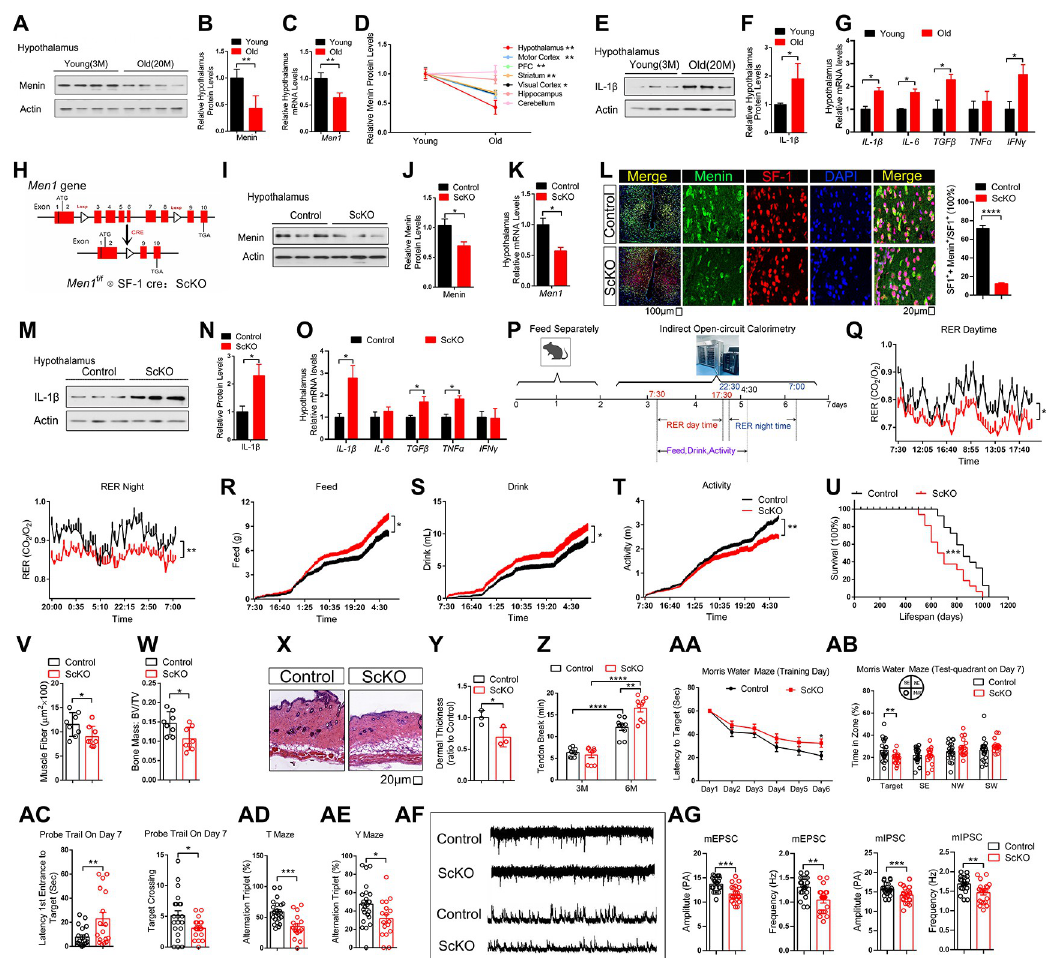
Fig 1. Reduced Menin in the hypothalamus accelerates systemic aging. AU : AbbreviationlistshavebeencompiledforthoseusedinFigs 1 to 6 : Pleaseverifythatallentriesarecorrect : (A–C) Menin protein expression and mRNA levels in the hypothalamus of young (3M) and old (20M) mice; n = 4 mice. (D) Menin protein expression levels in 7 regions of young (3M) and old (20M) mice brain; n = 4 mice. Actin serves as a loading control. (E–G) Inflammatory factors protein expression and mRNA levels in the hypothalamus of young (3M) and old (20M) mice; n = 3 mice. (H) Generation of conditional Men1 -knockout mice by crossing Men1 f/f mice with SF1 -Cre mice (ScKO). (I–K) The protein and mRNA levels of Menin in the hypothalamus of 6 months ScKO and control mice; n = 3 mice. (L) Representative hypothalamus brain sections from 6 months control and ScKO mice stained with Menin (green) and SF1 (red) antibody. Section was counterstained with DAPI (blue). Scale bar, 100 μ m, 20 μ m; n = 5 mice. (M–O) Inflammatory factors protein expression and mRNA levels in the hypothalamus of ScKO (6M) and control (6M) mice; n = 3 mice. (P) Schematic diagram of open circuit indirect calorimetry. (Q) Day and night respiratory quotients (RER) of age-matched male ScKO mice (10M) and control mice (10M) were measured. Exact dietary (R), water intake (S), and activity (T) were also measured. (U) Lifespan of these mice (Control mice, n = 14; ScKO mice, n = 16). (V–Z) Male mice were sacrificed at 10 months for measuring muscle (quadriceps) fiber size (V), bone mass (2), dermal thickness (X, Y), and tail tendon breaking time (Z); n = 3~9 mice. Scale bar, 20 μ m. (AA–AC) Ten months male ScKO and age-matched control mice behavior in Morris water maze tests. (AD) Ten months male ScKO and control mice behavior in T maze. (AE) Ten months male ScKO and control mice behavior in Y maze. (AF, AG) Electrophysiological recording from ScKO and control mice. Representative whole-cell recordings on SF-1 neurons in the hypothalamus of ScKO and control mice are shown on panel AF. Quantitation of their mEPSC and mIPSC frequency and amplitude are showed in panel AG ( n � 20 cells from 3 mice). Mouse number used in measuring energy expenditure by open circuit indirect calorimetry: ScKO mice: n = 16 mice; Control mice: n = 16 mice. Mouse number used in behavior tests: Control: n = 24 mice, ScKO mice: n = 17 mice. Data represent mean ± SEM, n.s.: not significant, � p < 0.05, �� p < 0.01, ��� p < 0.001, Kaplan–Meier survival estimate for survival curve. Unpaired t test for behavioral statistics. Statistical applications between groups across multiple time points were analyzed by repeated-measures ANOVA. Other statistical applications were analyzed by one-way ANOVA with Tukey’s post hoc analysis. The underlying data of Fig 1 can be found in S1 Information. mEPSC, miniature excitatory postsynaptic current; mIPSC, miniature inhibitory postsynaptic current; SF-1, steroidogenic